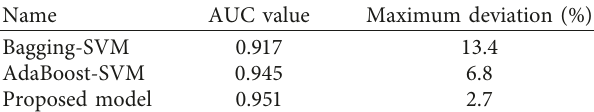
Table 7: The optimal value of model parameters.